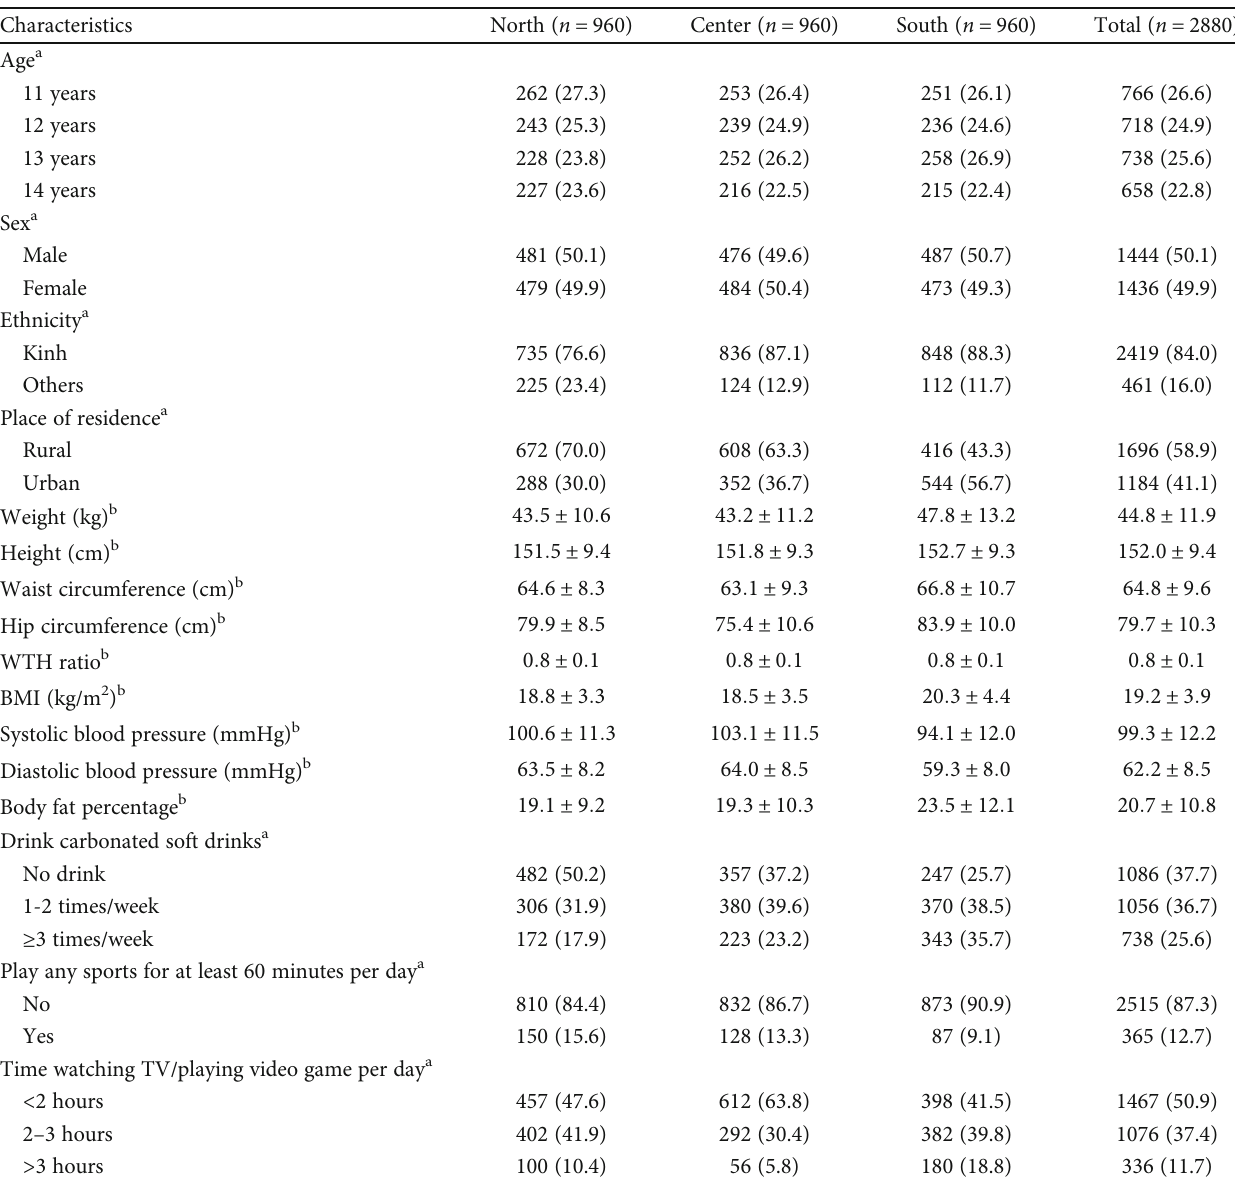
Table 1: Characteristics of